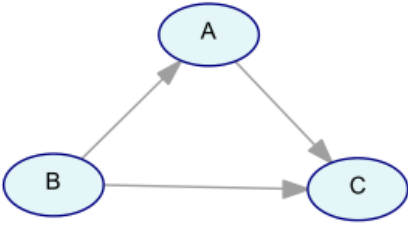
Figure 2. A basic Bayesian network.